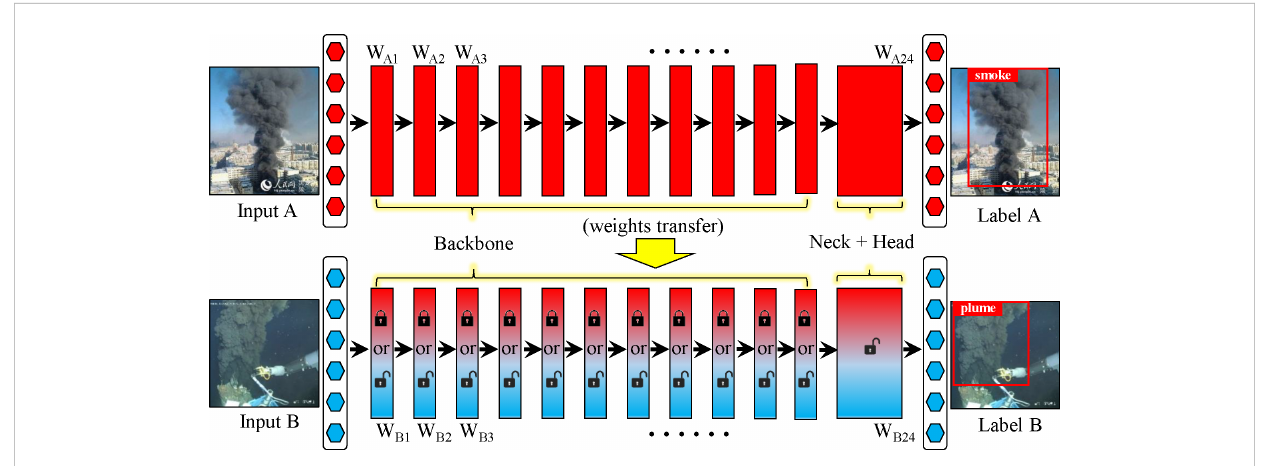
FIGURE 6 Overview of experimental treatments and controls of the transfer